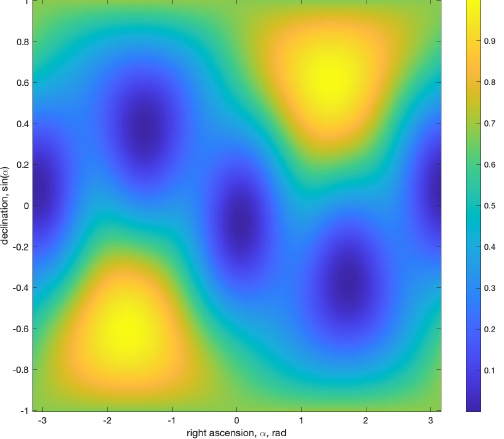
Figure 4. Antenna power pattern for Novosibirsk detector for the optimal angle.